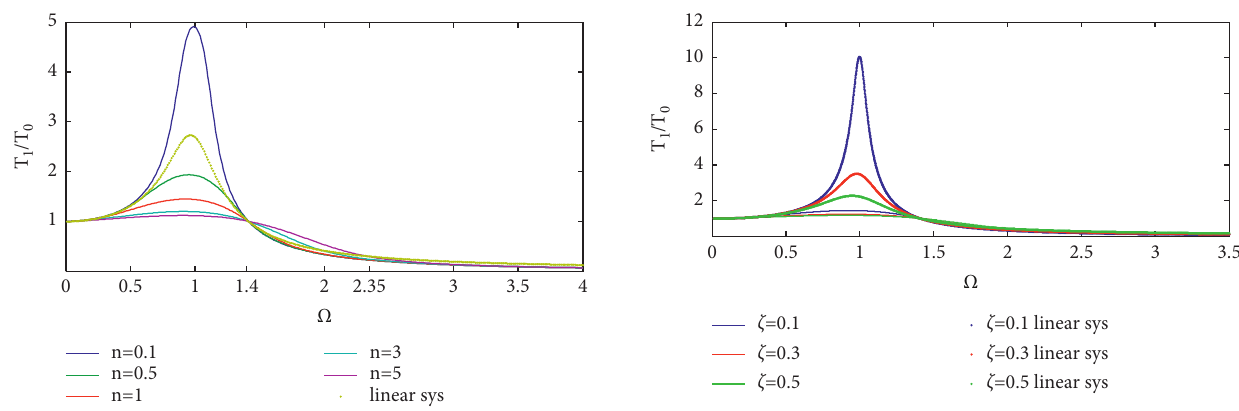
Figure 7: Force transmissibility-frequency ratio diagram for dif- ferent n .